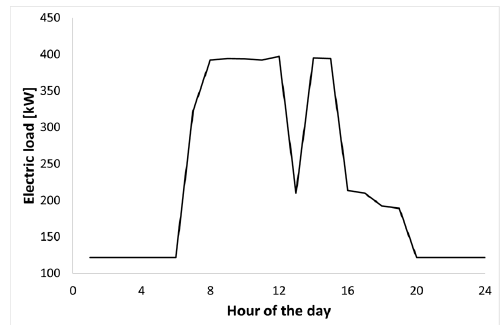
Figure 2. The electric load of the plant for sludge handling and preparation.